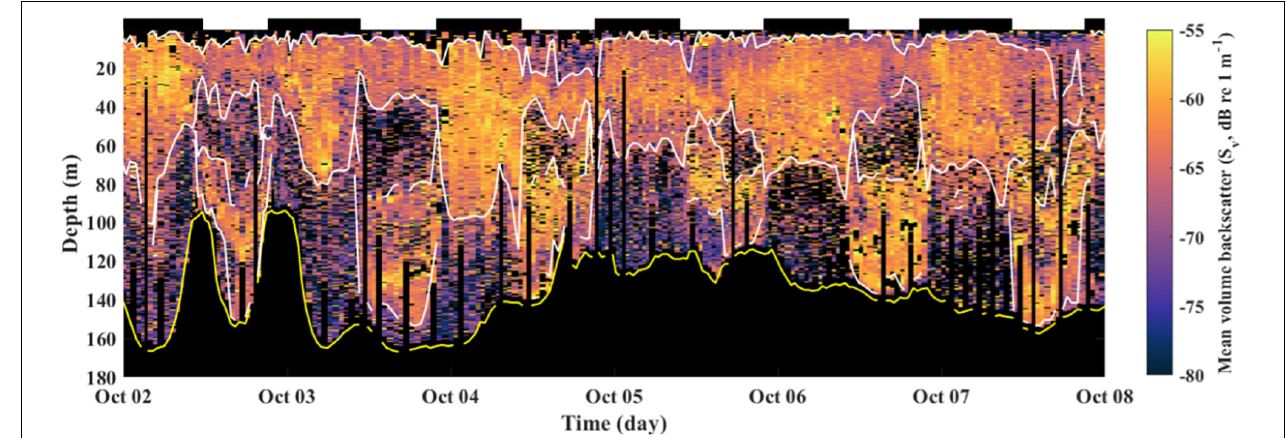
FIGURE 2 | Echogram of S v from 300 profiles taken during the first transit of Roseway Basin from 2 to 8 October 2015. Shallow and deep SLs are indicated with white lines; the acoustically derived depth of the seafloor is indicated with a yellow line. Black indicates no data (i.e., vertical bars are early inflections made by the glider or depths below the seafloor). Bars at the top of the panel show periods of day (white) and night